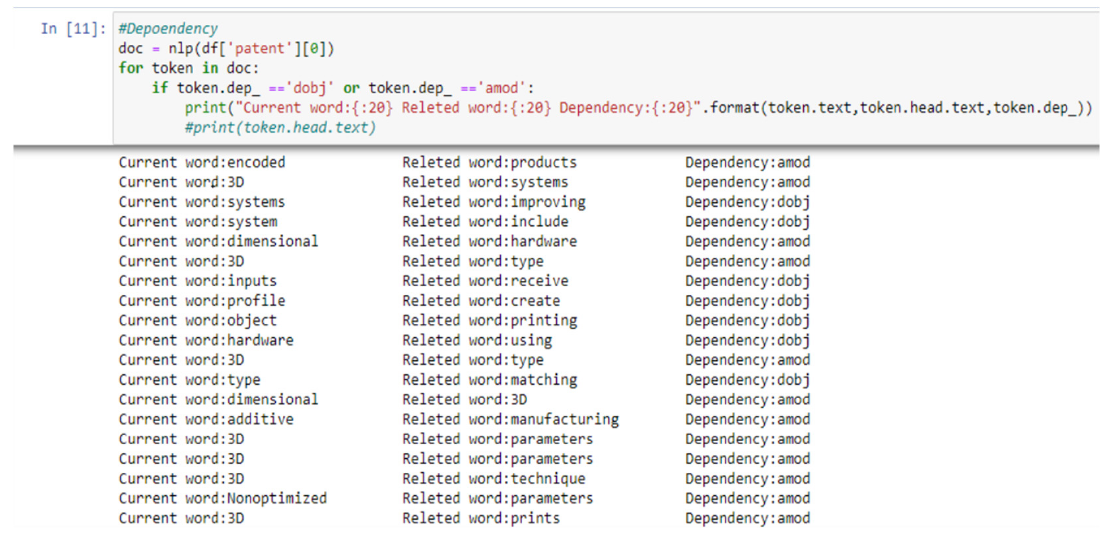
Figure 4. Dependency parsing of patent